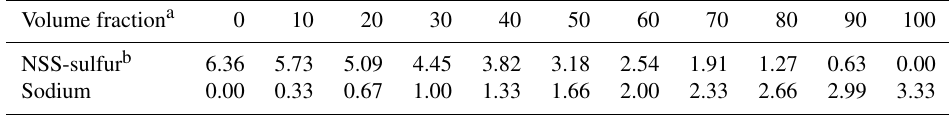
Table 1. Initial particle composition (ppb) in the box-modelling evaluation against AIM III. Volume fraction a